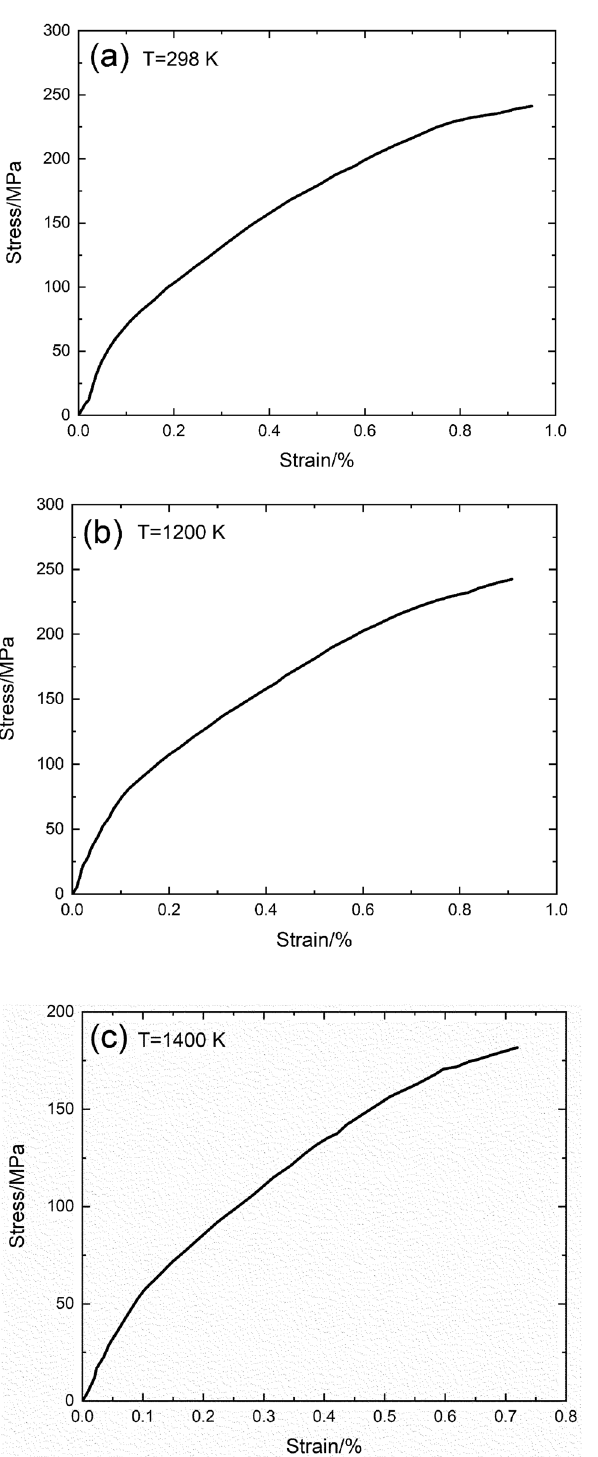
Figure 7: Experimental tensile stress – strain curves of Nicalon TM SiC/C/SiC at ( a ) T = 298 K, ( b ) T = 1,200 K, and ( c ) T = 1,400 K.